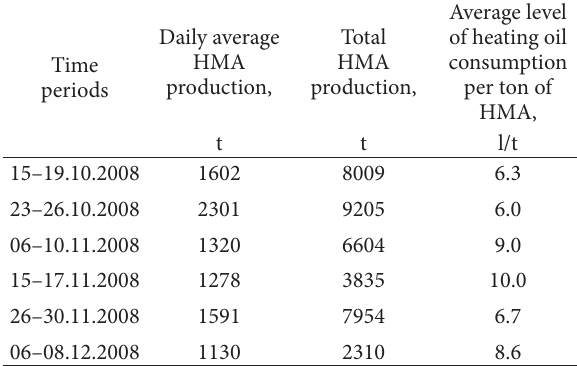
Table 3 . Fuel consumption in litres of fuel per ton of the produced HMA in 2008 Daily average Total HMA HMA Time production, production, periods